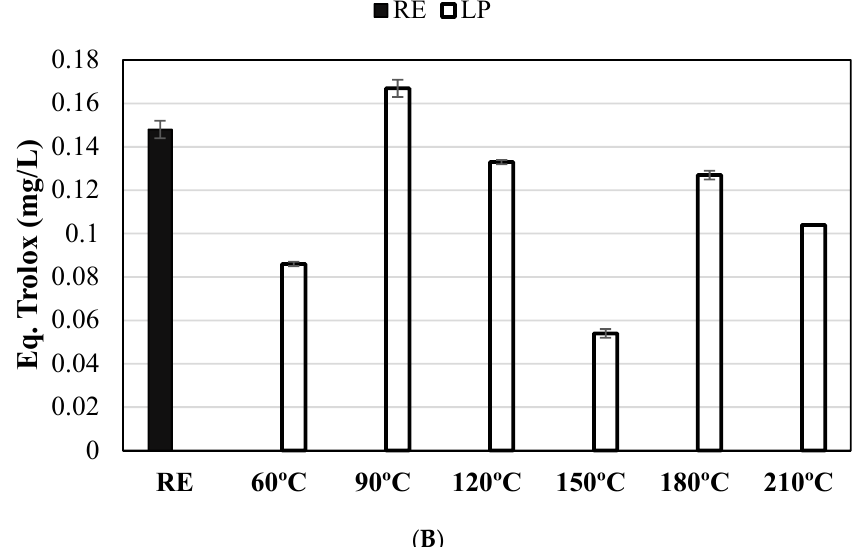
Figure 4. Antioxidant capacity determined by antiradical activity (DPPH) ( A ) and reducing power ( B ) methods of extrudate for untreated RE and each LP obtained after hydrothermal pre-treatments.